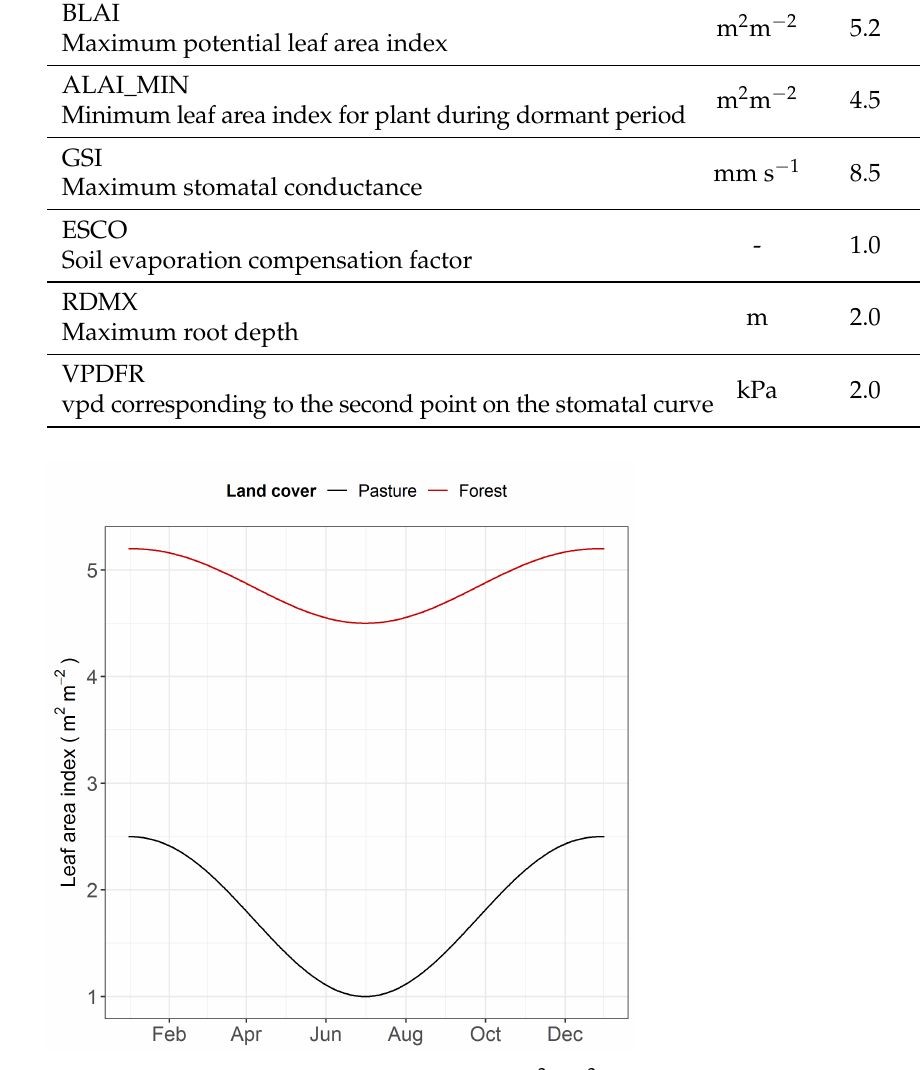
Figure A1. Daily variation of leaf area index, in m 2 m − 2 , in a year, for pasture (black line) and forest (red line) land